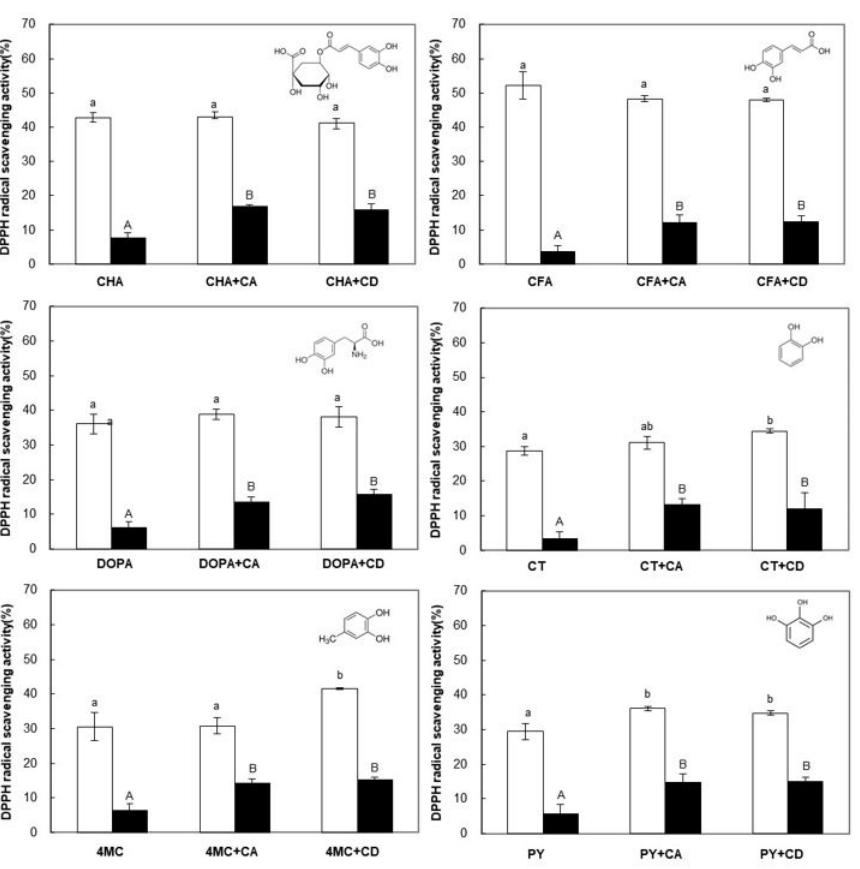
Figure 2. DPPH radical scavenging activities of phenolic compounds (CHA, chlorogenic acid; CFA, caffeic acid; DOPA, 3,4-Dihydroxy- L -phenylalanine; CT, catechol; 4MC, 4-methylcatechol; PY, pyrogallol) detected at 0 day (empty bar) and after 4 weeks (black bar) in the absence and presence of cyclic glucans (cycloamylose (CA) and cyclodextrin (CD)). The molecular structure of each phenolic compound is shown in the upper right of the bar graph. The error bars represent the mean and standard deviations ( n = 3). Bars with the different letter (a and b for white bars; A and B for black bars) are significantly different based on Tukey’s test at p <